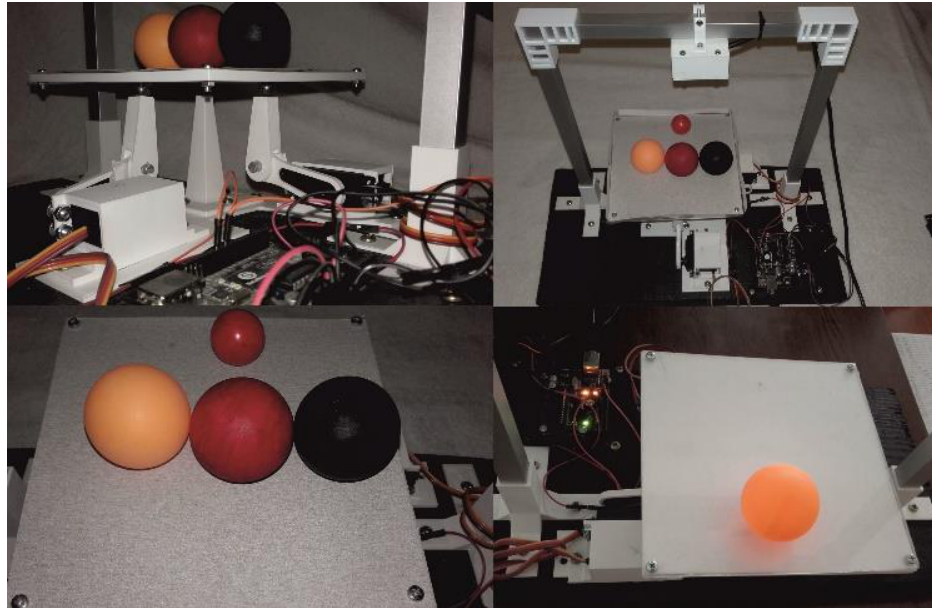
Figure 13. Educational BPS system with three experimental balls. Three balls with identical sizes but different colours were chosen for the experiment, as indicated in Figure 13 bottom and left segments. Table tennis balls with a diameter of 40 mm were chosen in the following order: black, red, and orange. A smaller red ball with a diameter of 20 mm was utilized as a comparison, composed of a silicone mixture with a substantially higher mass. The ball was moved using a variety of materials with varying friction properties: 3D print material, two millimetre Plexiglas cover plate, white paper, and light grey sandpaper (180 particles per inch). The chosen materials had varying roughness values, which resulted in unequal resistance during the movement of the test balls over time. The white 3D printed platform plate is 150 × 150 mm and is supported by three supports, or pillars, the middle of which is vertically immobile and located in the geometric centre of the platform’s square surface. A simple dry “magnetic” bearing with a metallic ball and a magnetic cup on the underside of the platform in the geometric centre was designed to tilt the platform in both horizontal axes. When the DC servo motor’s two vertical robotic arms are raised and lowered, the platform tilts in firm contact with the robotic handle through a dry bearing on one side or the other. Servo motors are connected to the lower half of the motor with steerable arms with a wedge in the elbow, as shown in Figure 13 above and left. They are at a 90-degree angle to each other geometrically, and the grips are equidistant from the central fixed bearing. The servo motor handle’s horizontal portion (first arm) is attached to the servo motor protrusion, while the vertical portion (second arm with jaws) includes a spherical metallic ball glued to the top and a magnetic cup. Because the cup is fastened in the lower half of the steerable base, they form a firm and dry bearing that facilitates rotation. A simple robotic lever system was created using a solid elbow and a shaft with a wedge diameter of 4mm as a dry bearing, in which both DC servo motors with a rotating angle of ± 15 degrees transmit the same angular motion to the BPS